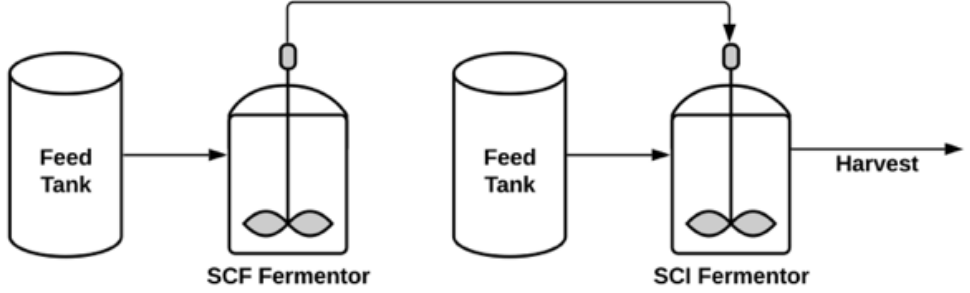
Figure 2. A simplified process flow diagram of the proposed SCF/SCI system where SCF and SCI are fermenters for bacteria and phage amplification, respectively. All the control systems are excluded to provide a simple depiction of the system. Adapted from [69].